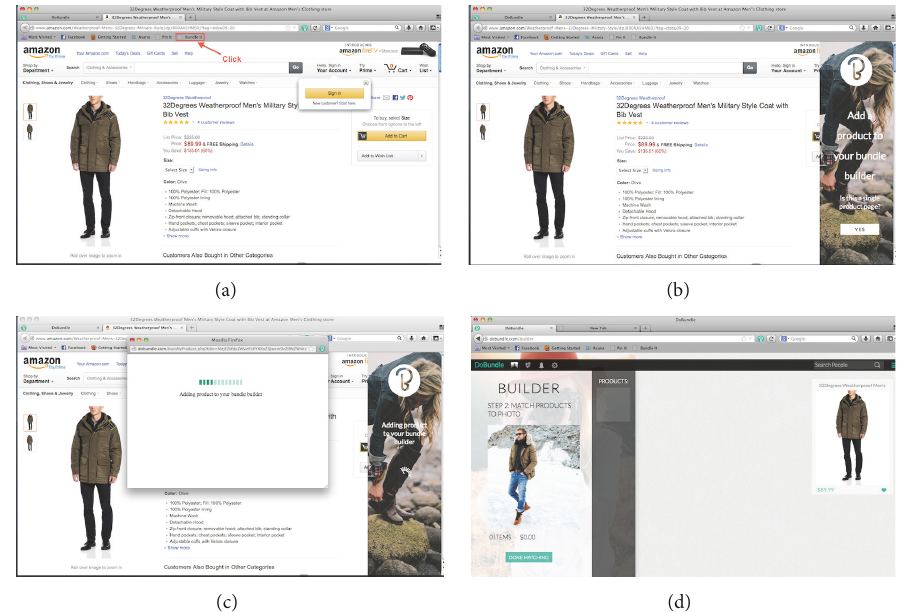
Figure 5: Collecting an online product. (a) User surfs to the URL of the first product they want to match with their image; (b) user clicks on the “Bundle It” bookmarklet. It shows a side panel to fetch the product information; (c) product information is sent to the user’s online account; and (d) product appears on the user’s account page.